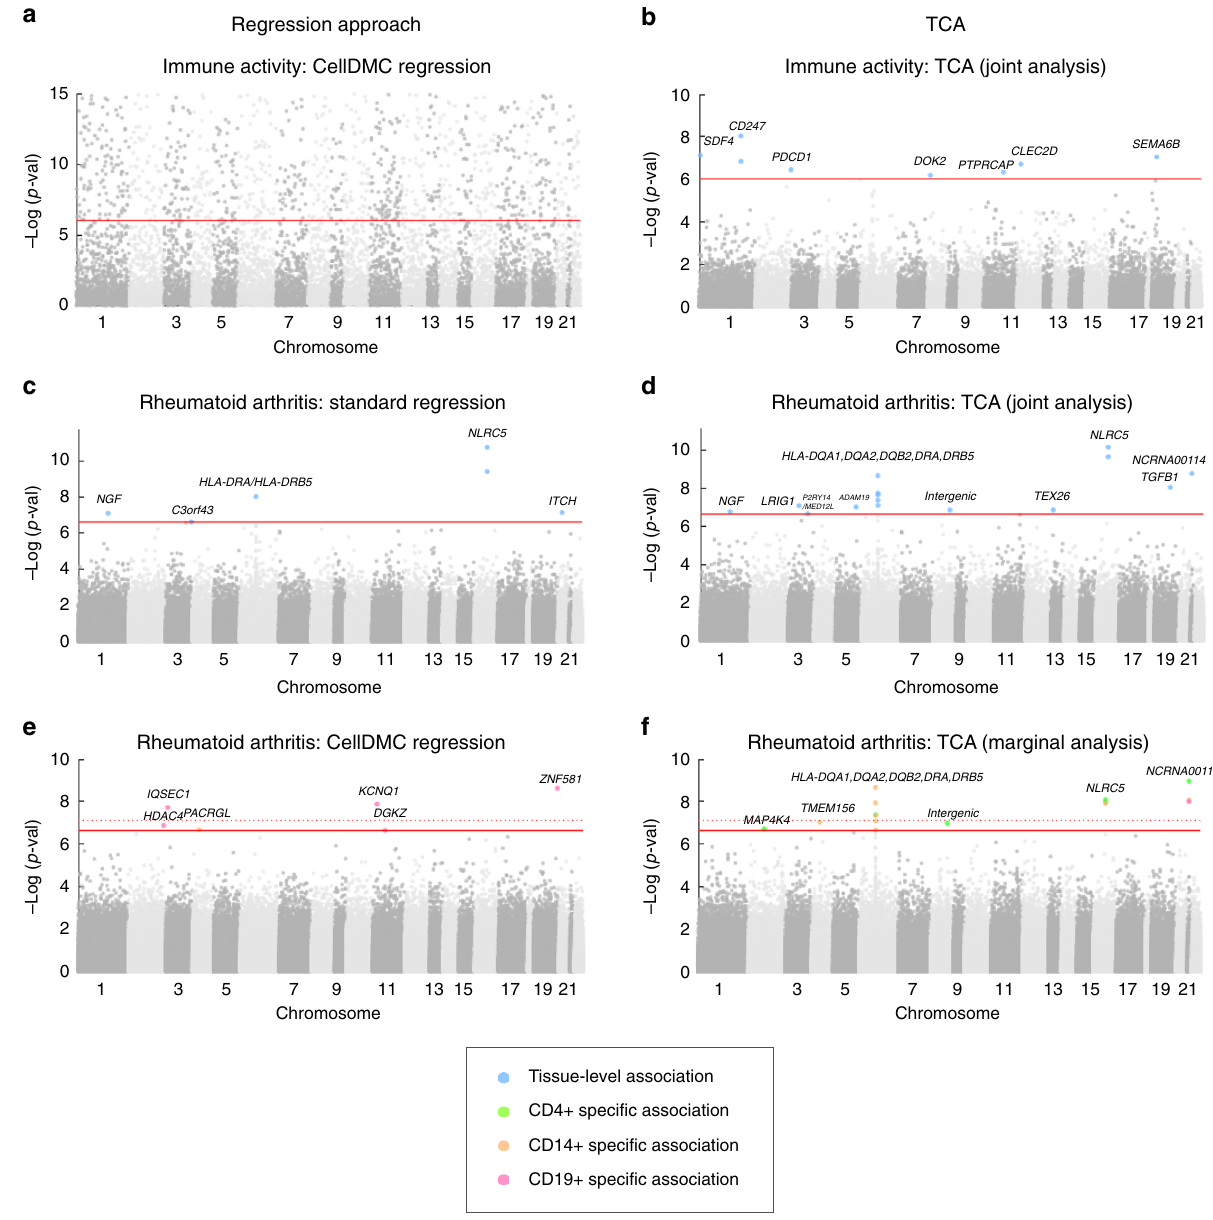
Fig. 4 Results of the association analysis with level of immune activity and with rheumatoid arthritis in the Liu et al. whole blood methylation data, presented by Manhattan plots of the − log10 P -values for the association tests. a , b Shown are results with immune activity using CellDMC (results subsampled and truncated for visualization) and using TCA. c , d Shown are results of the RA analysis using standard regression and using TCA under the assumption of a single effect size for all cell types. e , f Shown are results of a cell-type-speci fi c analysis of RA using CellDMC and using TCA. Solid horizontal red lines represent the experiment-wide signi fi cance threshold, and dotted horizontal red lines represent the signi fi cance threshold adjusted for three experiments corresponding to the three cell